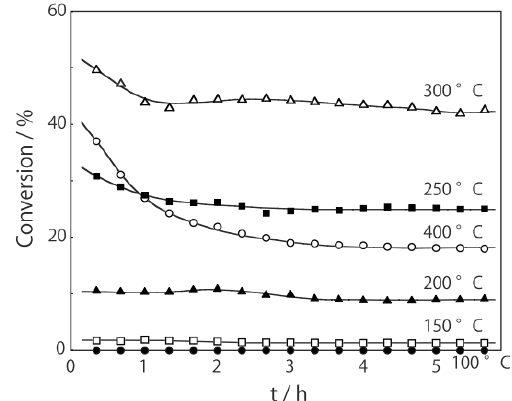
Figure 8. Typical reaction profiles of decomposition of phenyl acetate to phenol and ketene catalyzed by [(Nb activation of the cluster (30 mg, 25 μmol) in a helium stream (2.4 L/h) for 1 h, reaction was initiated by introduction of phenyl acetate (0.1 mL/h, 0.79 mmol/h) to the helium stream